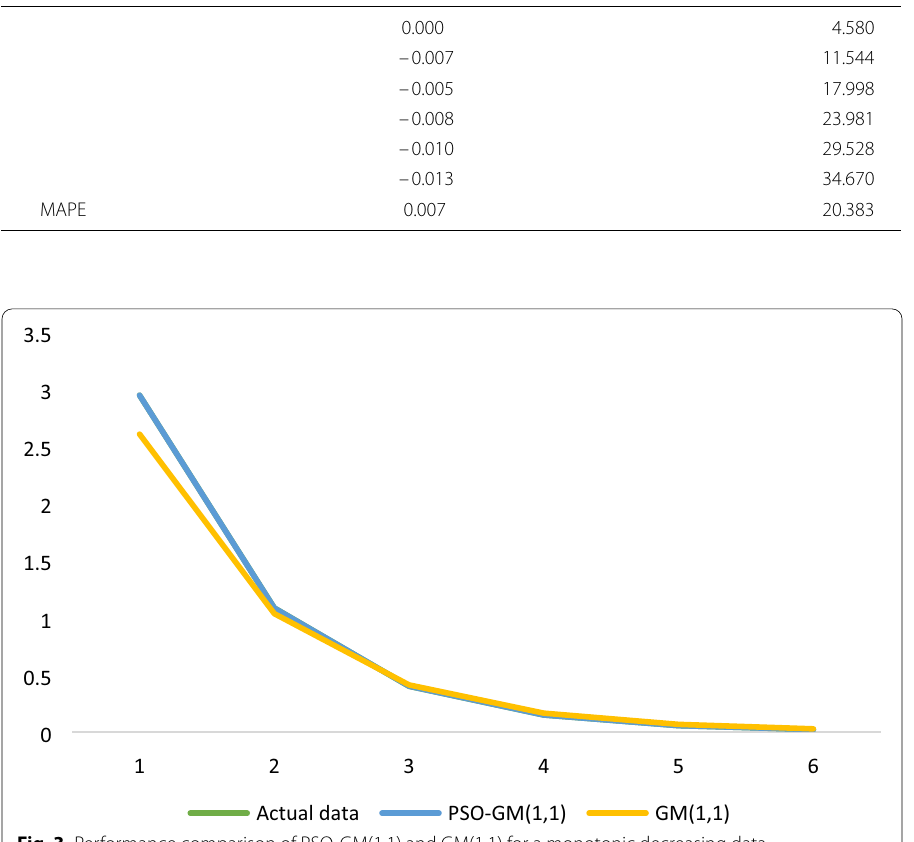
Fig. 3 Performance comparison of PSO-GM(1,1) and GM(1,1) for a monotonic decreasing